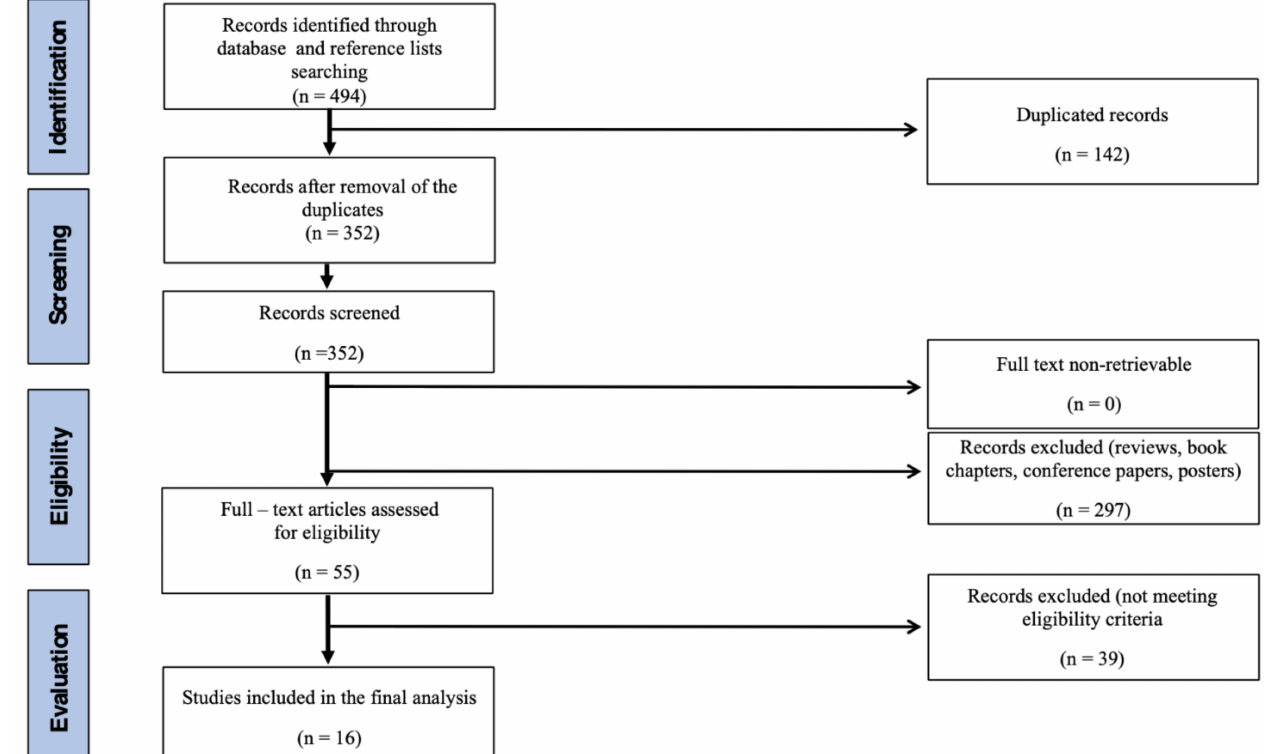
Figure 1. Flowchart showing how the reviewed articles were identified and